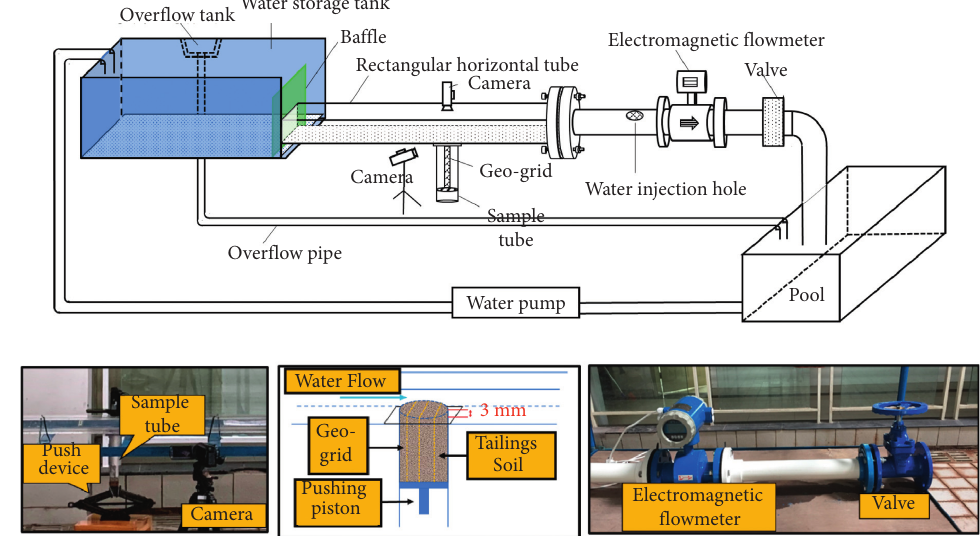
Figure 1: Erosion apparatus to measure erodibility.